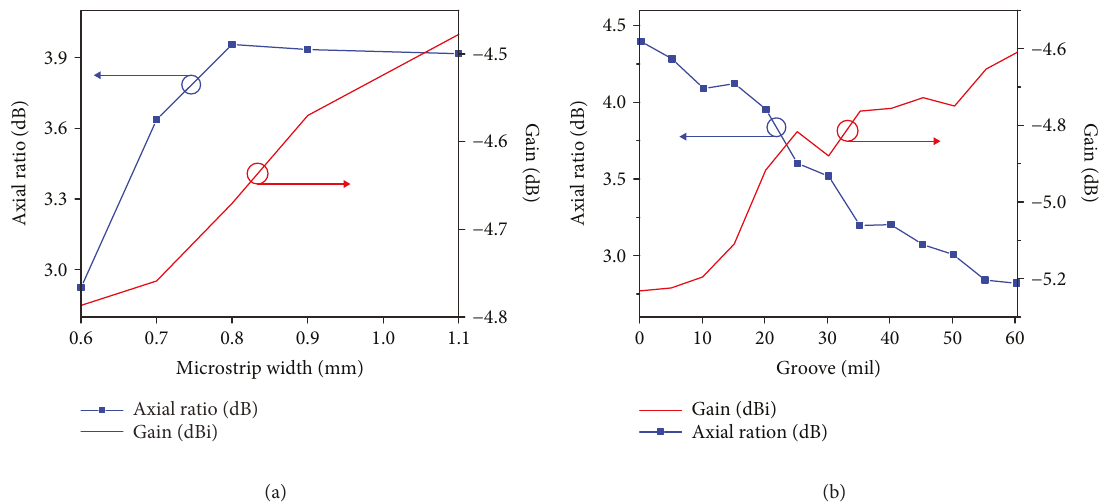
Figure 5: Trend of gain and axial ratio with (a) tapering and (b) cavity groove.